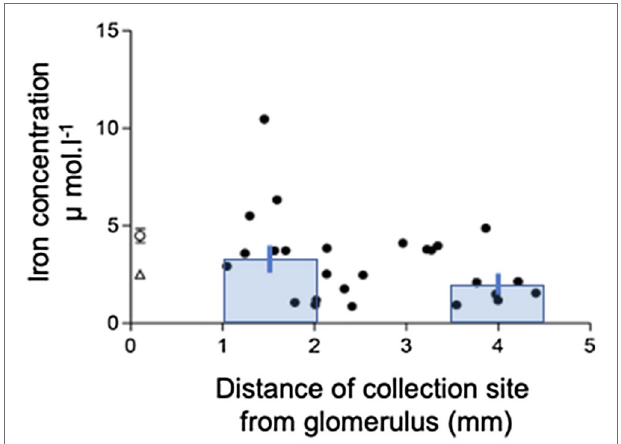
FIGURE 1 | Iron concentration profile along the S2 renal proximal convoluted tubule (PCT). Iron concentration in collection measured by FAAS plotted against distance of collection from glomerulus. Data are plotted for individual tubular fluid collections from 7 animals. Equation of regression line y = 5.026– 0.738x; n = 22; r 2 = 0.13. Bars show mean ± SEM for collections made in early part of S2 (1-2mm from glomerulus) 3.3 ± 0.6 μ mol.l − 1 , n = 10) and late part of S2 (3.5–4.5 mm from glomerulus) 2.1 ± 0.5 μ mol.l − 1 , n = 7. Comparison of these two means by unpaired t test yielded a value of p =